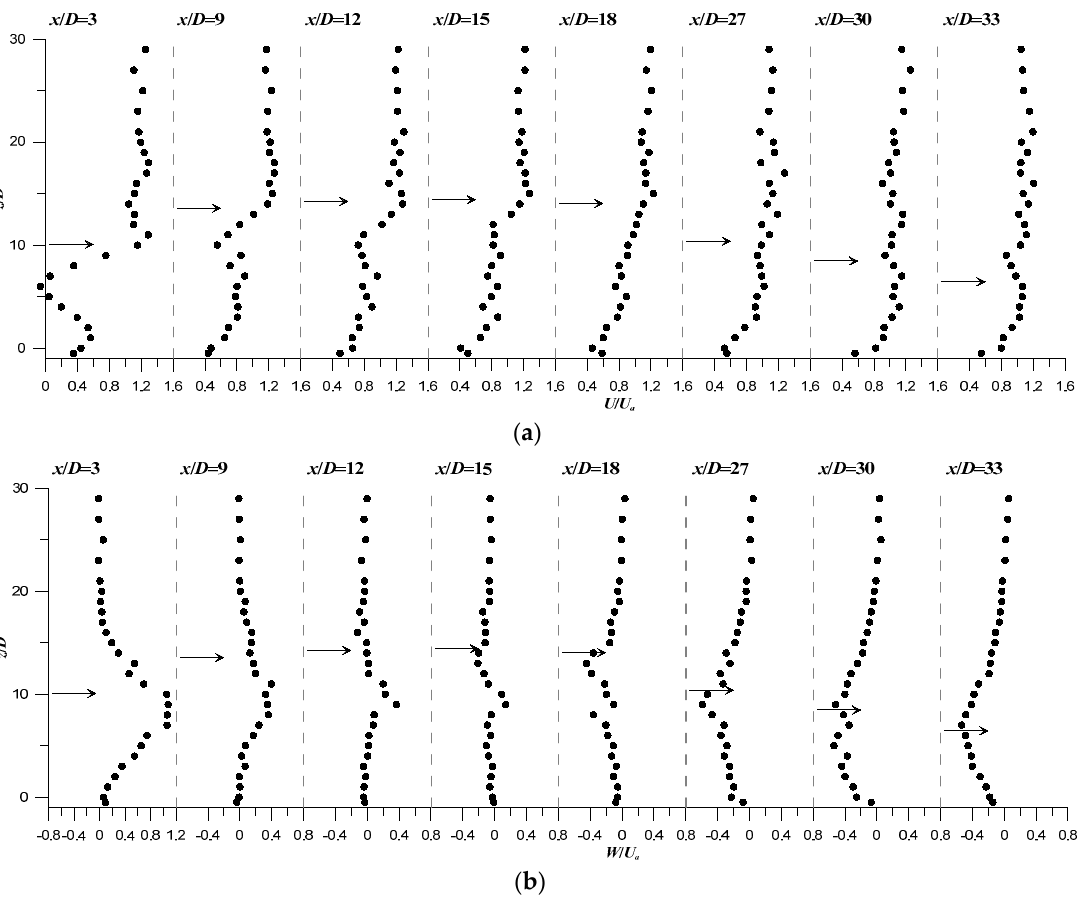
Figure 5. Normalized velocity profiles in the plane of flow symmetry ( y = 0) of run R2 at u r = 0.109 and u r F = 1.071: ( a ) U / U a ; ( b ) W / U a .